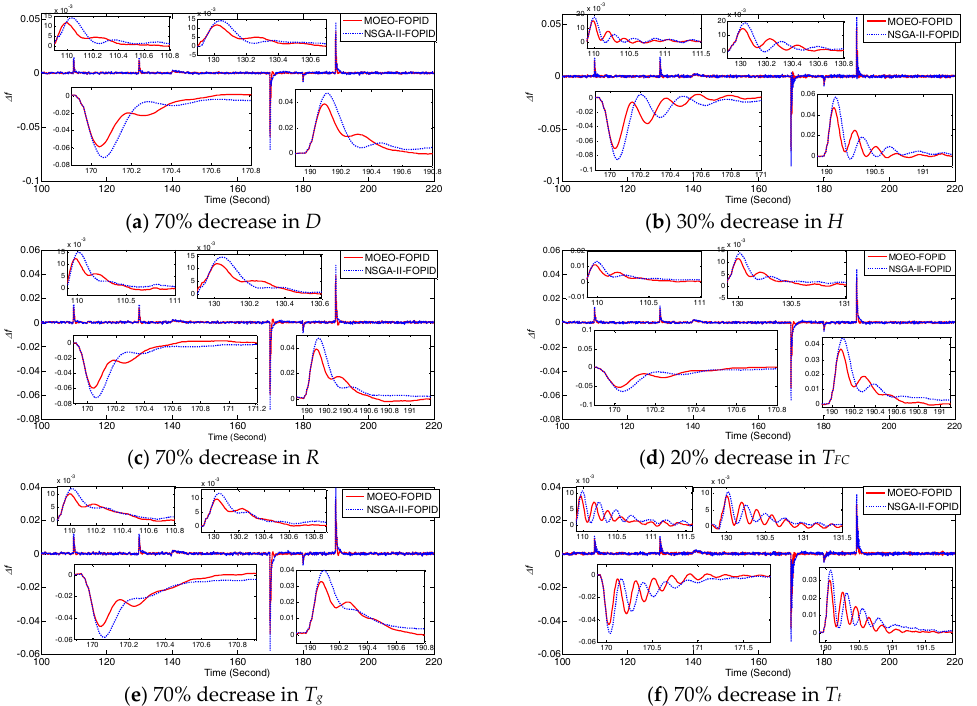
Figure 11. Comparison of the robustness against decreased system parameters obtained by MOEO-FOPID and